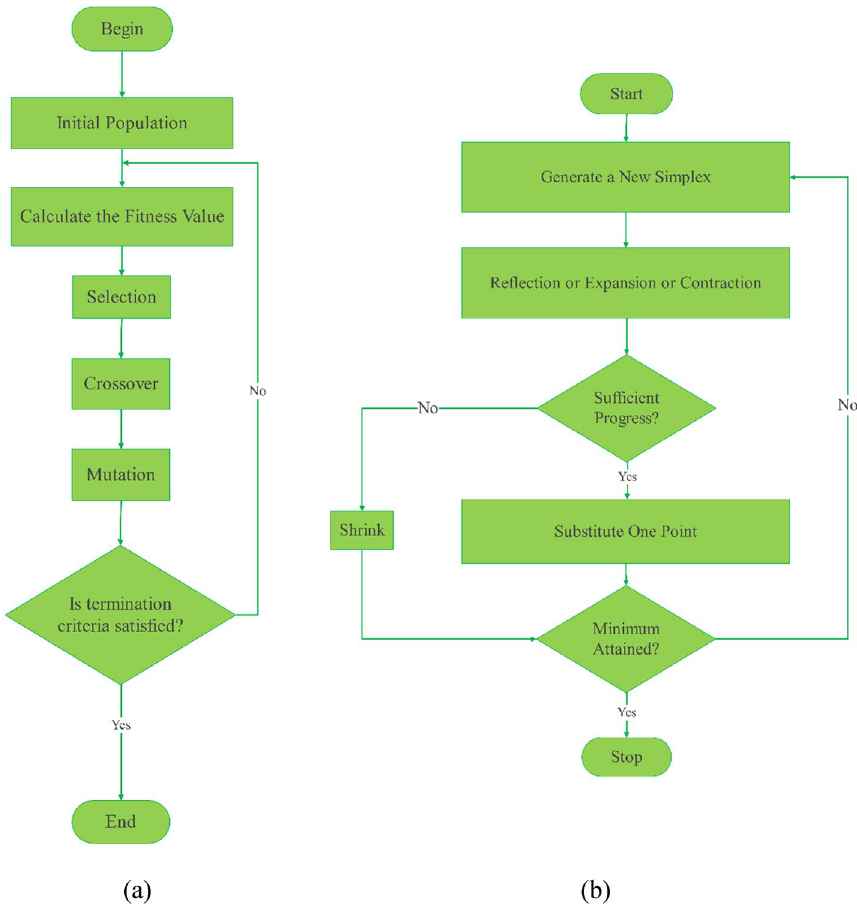
Fig. 4 Flowchart of a genetic algorithm b Nelder–Mead simplex method (Albadr et al. 2020; Barati